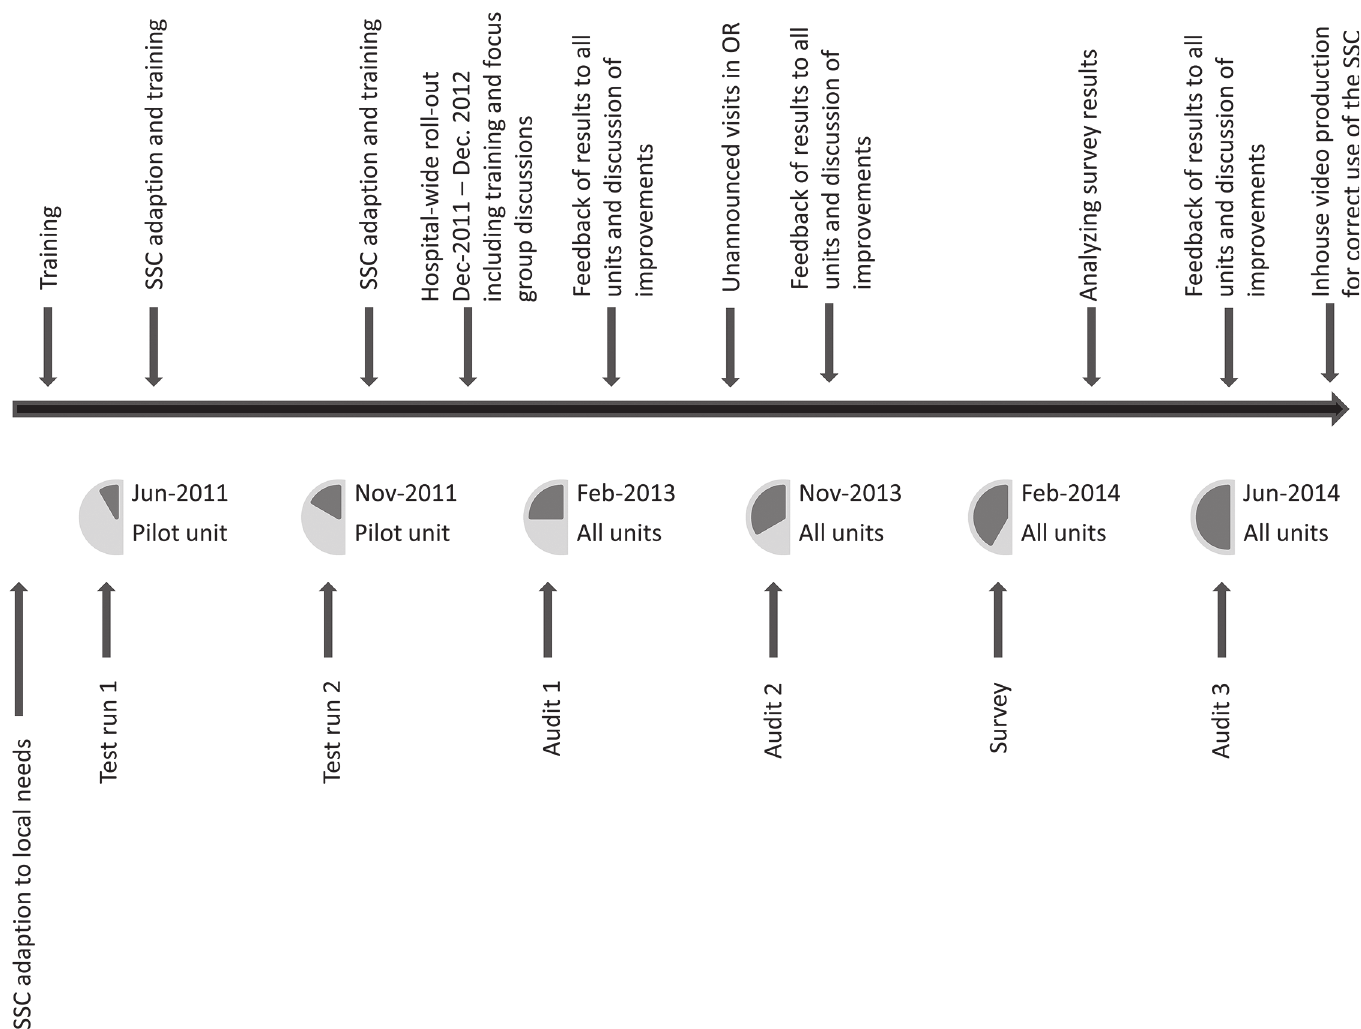
Fig 1. Details on the chronology of the implementation, modification and intervention